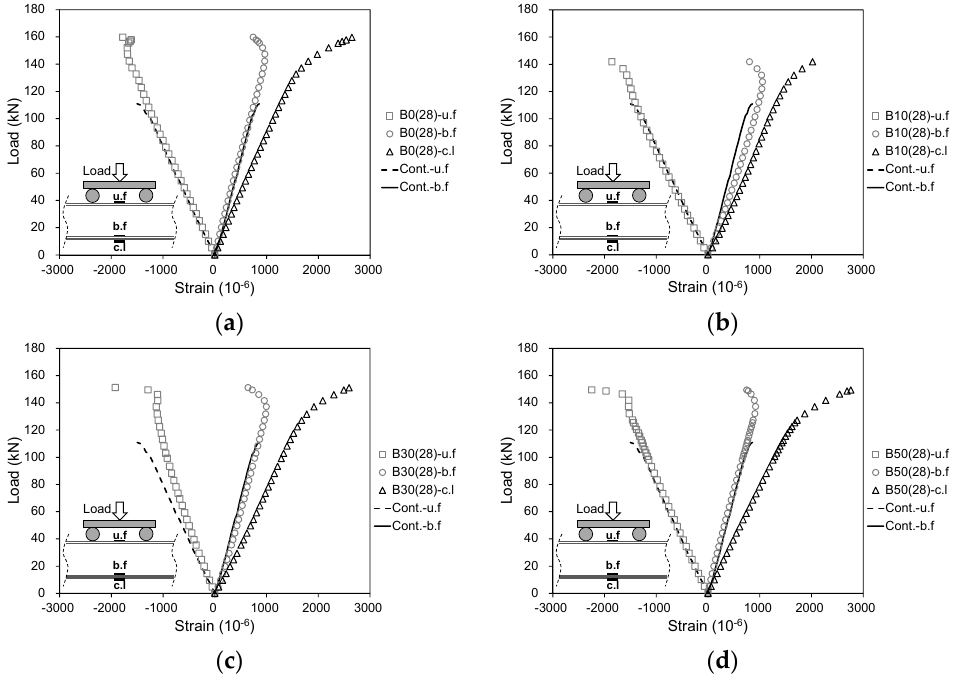
Figure 8. Load-strain responses of beams tested at 28 days: ( a ) Beam B0; ( b ) Beam B10; ( c ) Beam B30; ( d ) Beam B50.